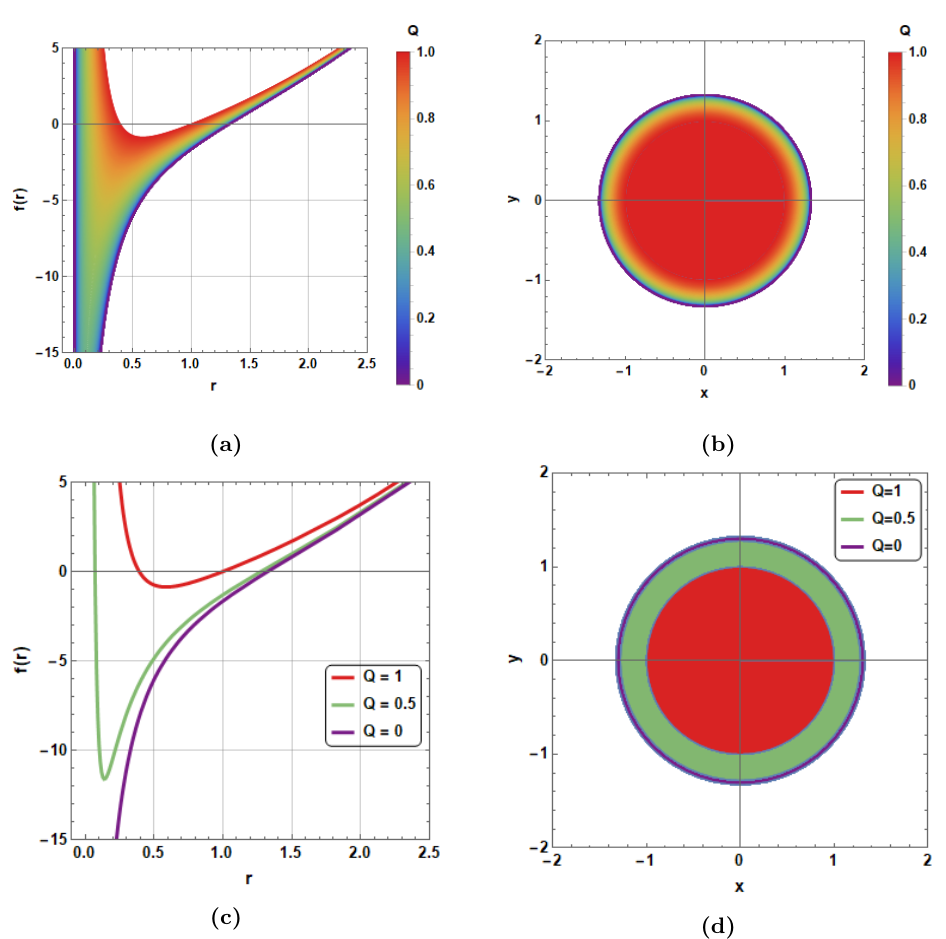
Figure 23. (a) and (c): evolution of f ( r ) function during absorption of 10 3 particles with a fixed electric charge dQ = − 0 . 001 . (b) and (d): evolution of black hole projection on xy plan during absorption of 10 3 particles with a fixed electric charge dQ = − 0 . 001 . The initial conditions are Q 0 = 1 , l = 1 , M 0 = 1 . 5 , r h = 1 and D = 4